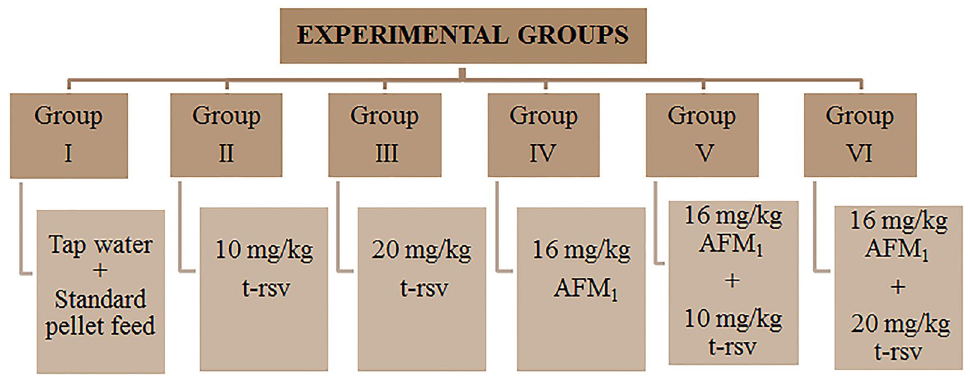
Figure 1. Experimental groups of the